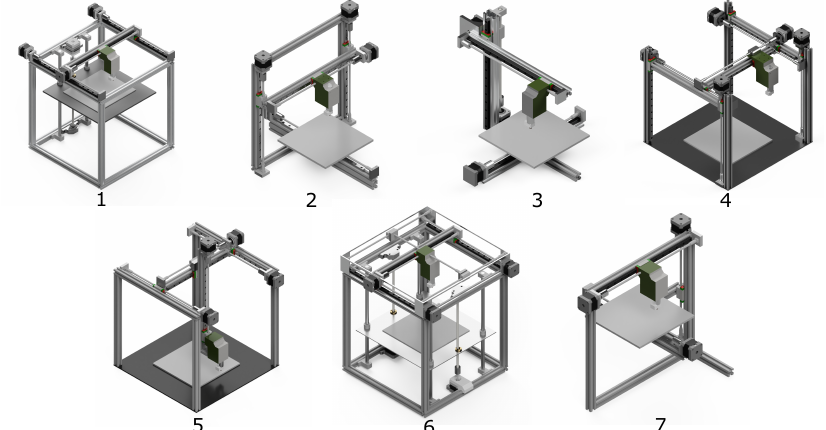
Figure 11. Common printer designs used in the